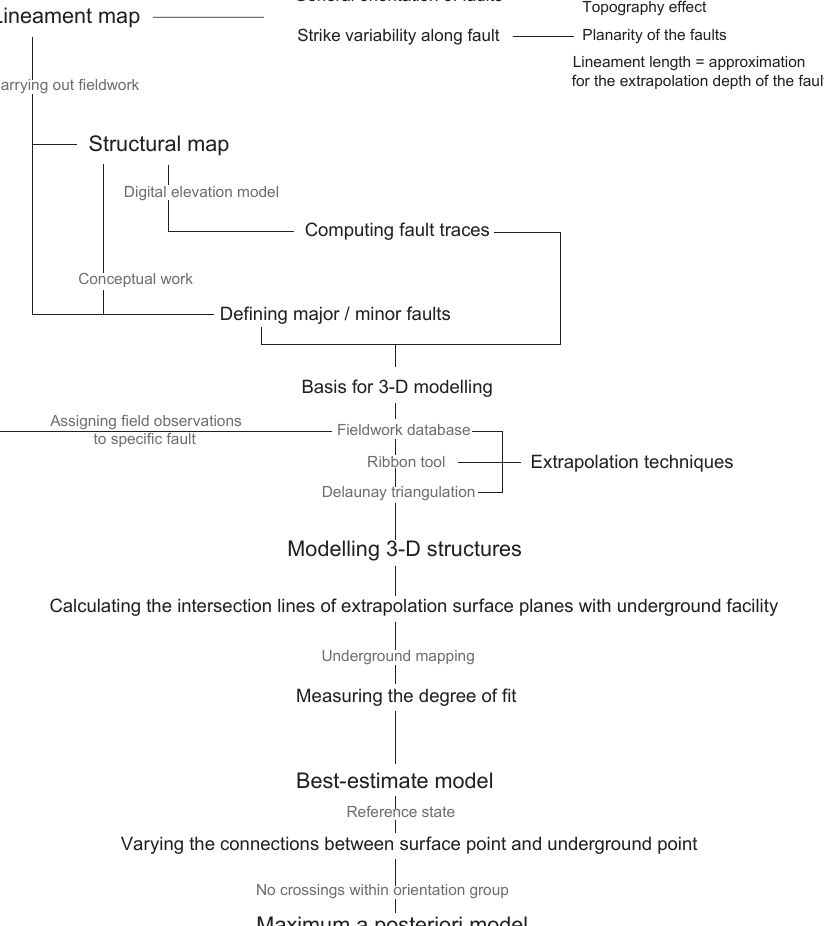
Figure 3. Employed modelling workflow to generate a 3-D structural model of the area based on a surface lineament map. As a major step, the workflow also considers the uncertainty related to the connection between mapped faults at the surface and